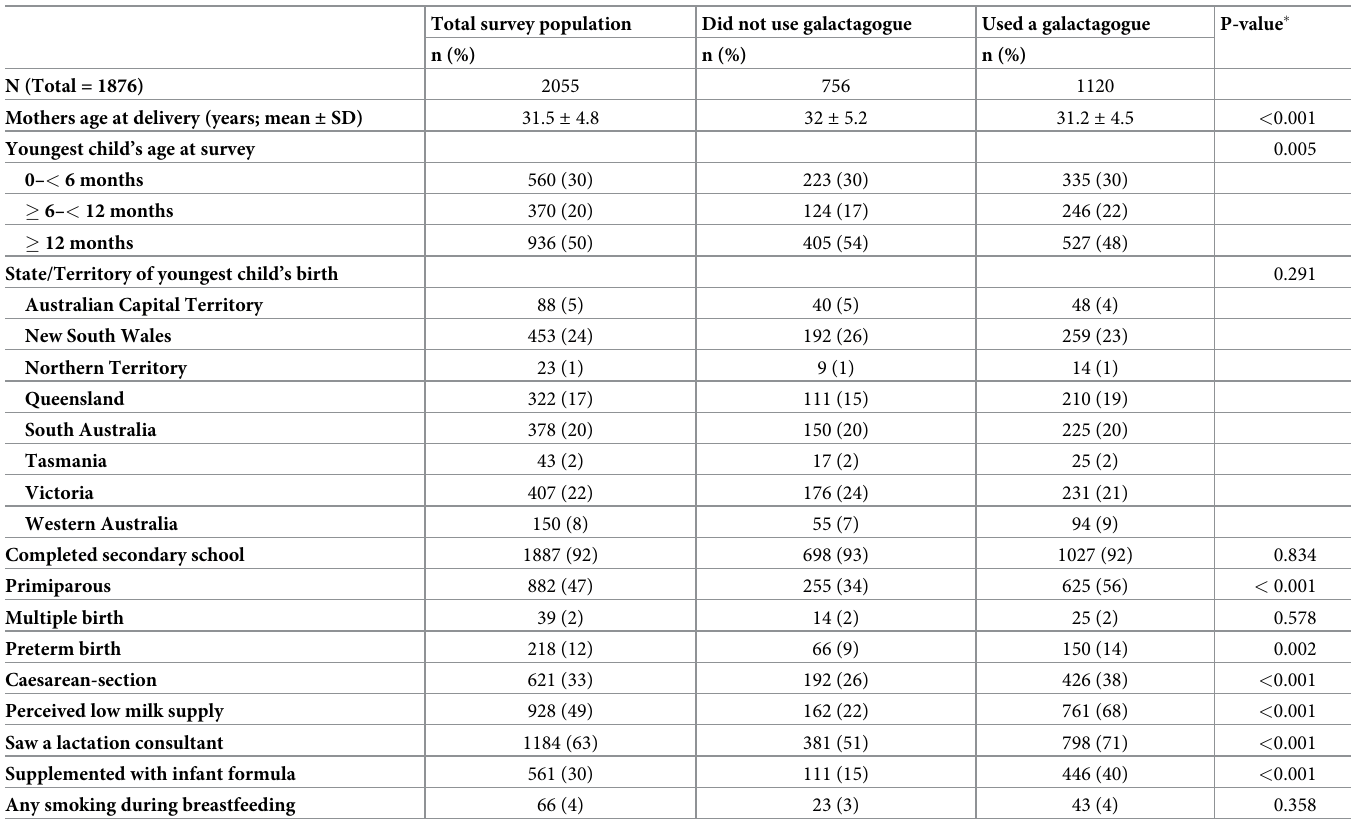
Table 1. Maternal characteristics according to any reported use of a galactagogue during